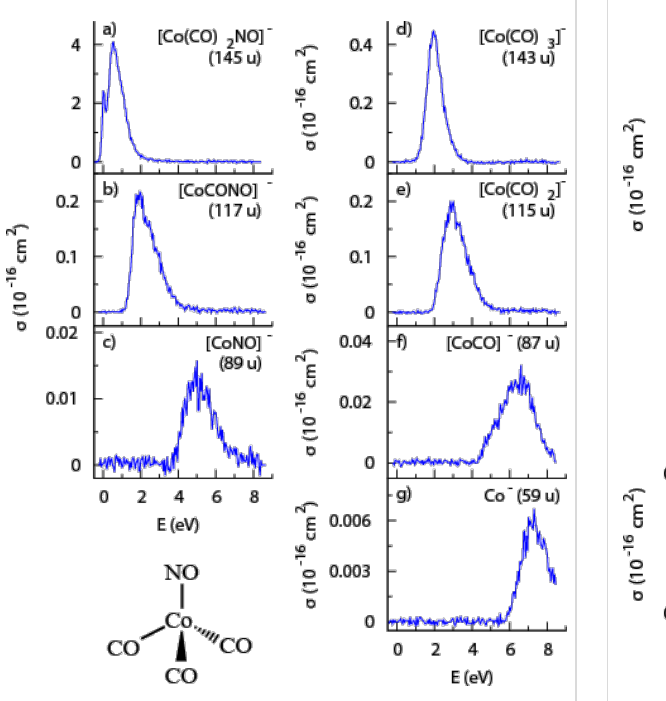
Figure 17: Energy-dependent absolute DEA cross sections for Co(CO) 3 NO (reproduced with permission from [10], Copyright (2013) American Institute of Physics).